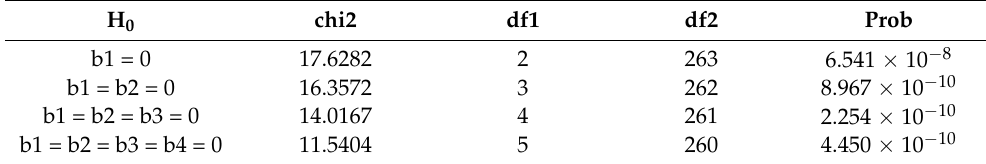
Table 3. Linear tests.